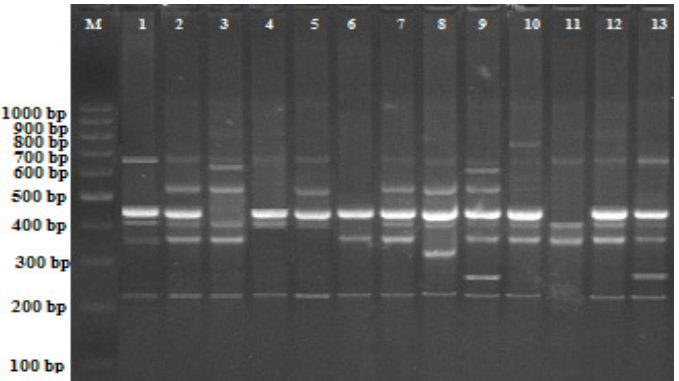
Figure 1. iPBS profiles for various experimental groups with 2391 primers in wheat. M, 100–1000 bp DNA ladder; 1, control; 2, MS medium containing 0X ZnO NPs; 3, MS medium containing 1X ZnO NPs; 4, MS medium containing 2X ZnO NPs; 5, MS medium containing 3X ZnO NPs; 6, MS medium containing 0X CuO NPs; 7, MS medium containing 1X CuO NPs; 8, MS medium containing 2X CuO NPs; 9, MS medium containing 3X CuO NPs; 10, MS medium containing 0X γ -Fe 3 O 4 NPs; 11, MS medium containing 1X γ -Fe 3 O 4 NPs; 12, MS medium containing 2X γ -Fe 3 O 4 NPs; 13, MS medium containing 3X γ -Fe 3 O 4 NPs.